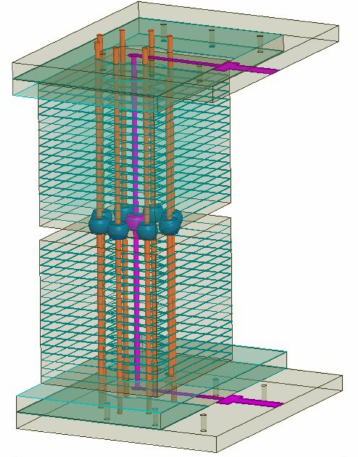
Figure 5. Coaxial-like microstrip simulation model.